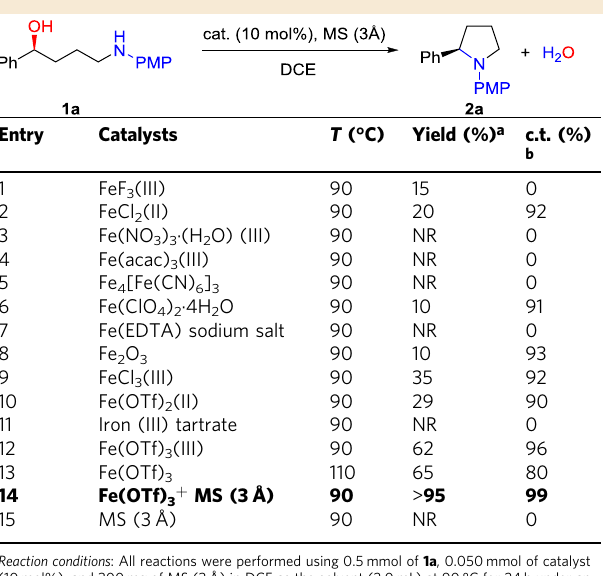
refer to loss of ee Bold entry indicates the optimized conditions